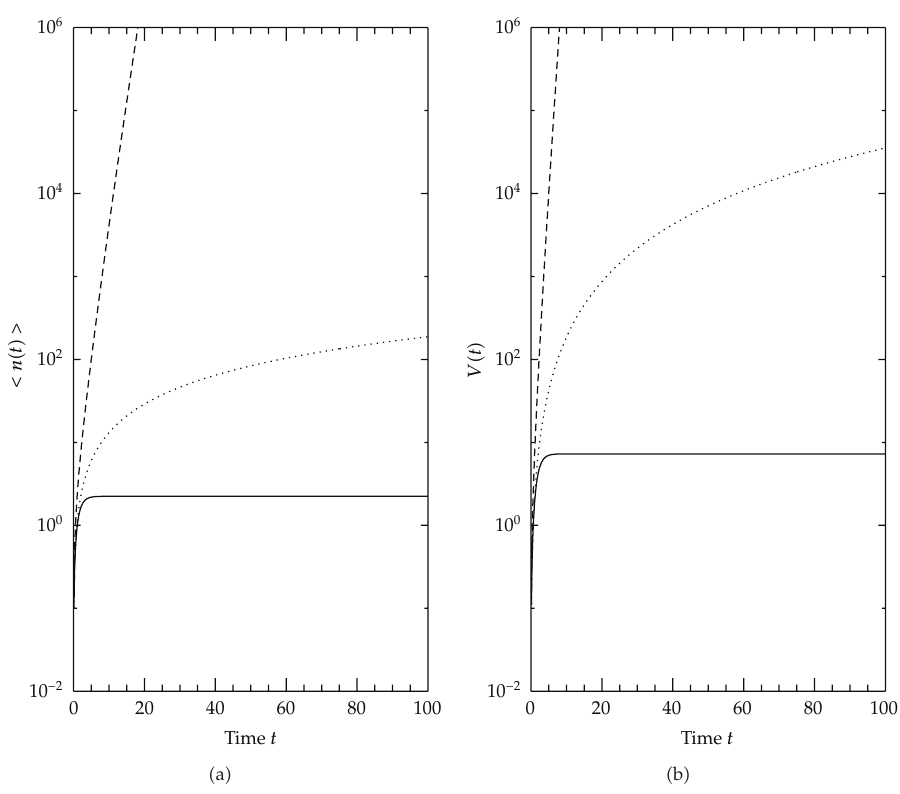
Figure 3: Time-dependence of the mean and the variance of three relaxation functions for κ (cid:3) t (cid:4) in Table 2: (cid:3) i (cid:4) an exponential relaxation (cid:3) solid line (cid:4) , (cid:3) ii (cid:4) an inverse power function (cid:3) dotted line (cid:4) , (cid:3) iii (cid:4) a fractional power function (cid:3) dashed line (cid:4) ; the values of parameters are κ (cid:7) 1, γ (cid:7) 0 . 85, α (cid:7) 1, and β (cid:7) 1.